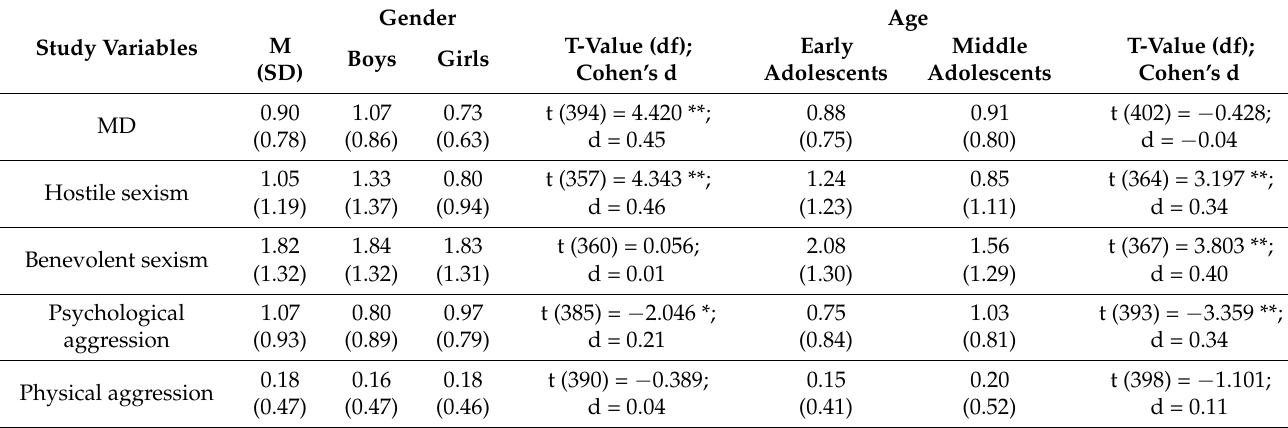
Table 3. Descriptive analysis by gender and age.